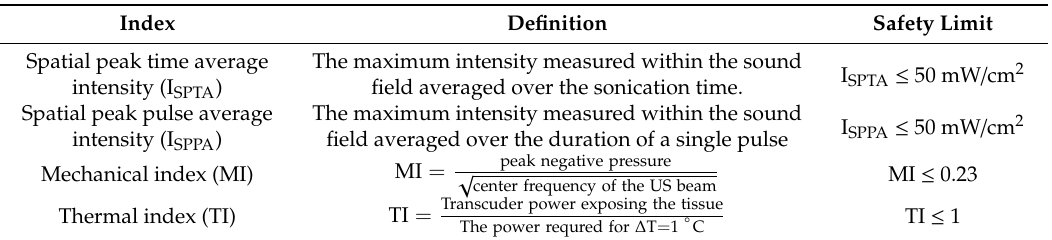
Table 1. Safety guidelines for ophthalmological ultrasound applications, according to